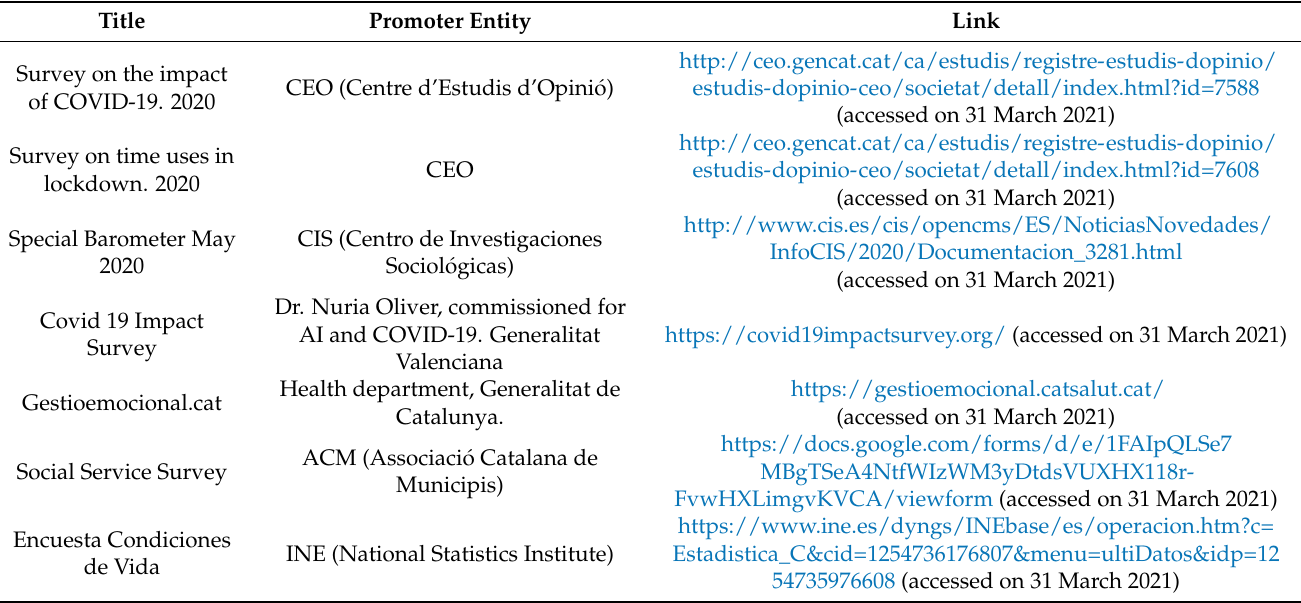
Table 1. State of the Art main